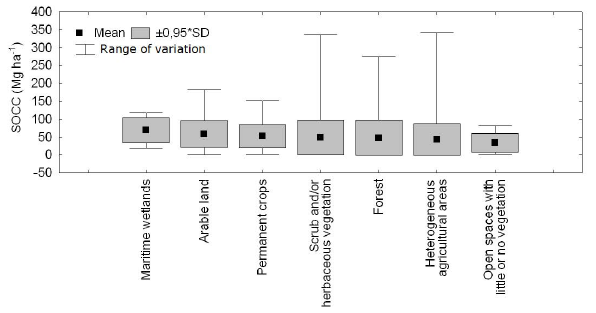
Fig. 3. Soil organic carbon content (SOCC) for each land use type. SD: standard deviation (0–75cm).